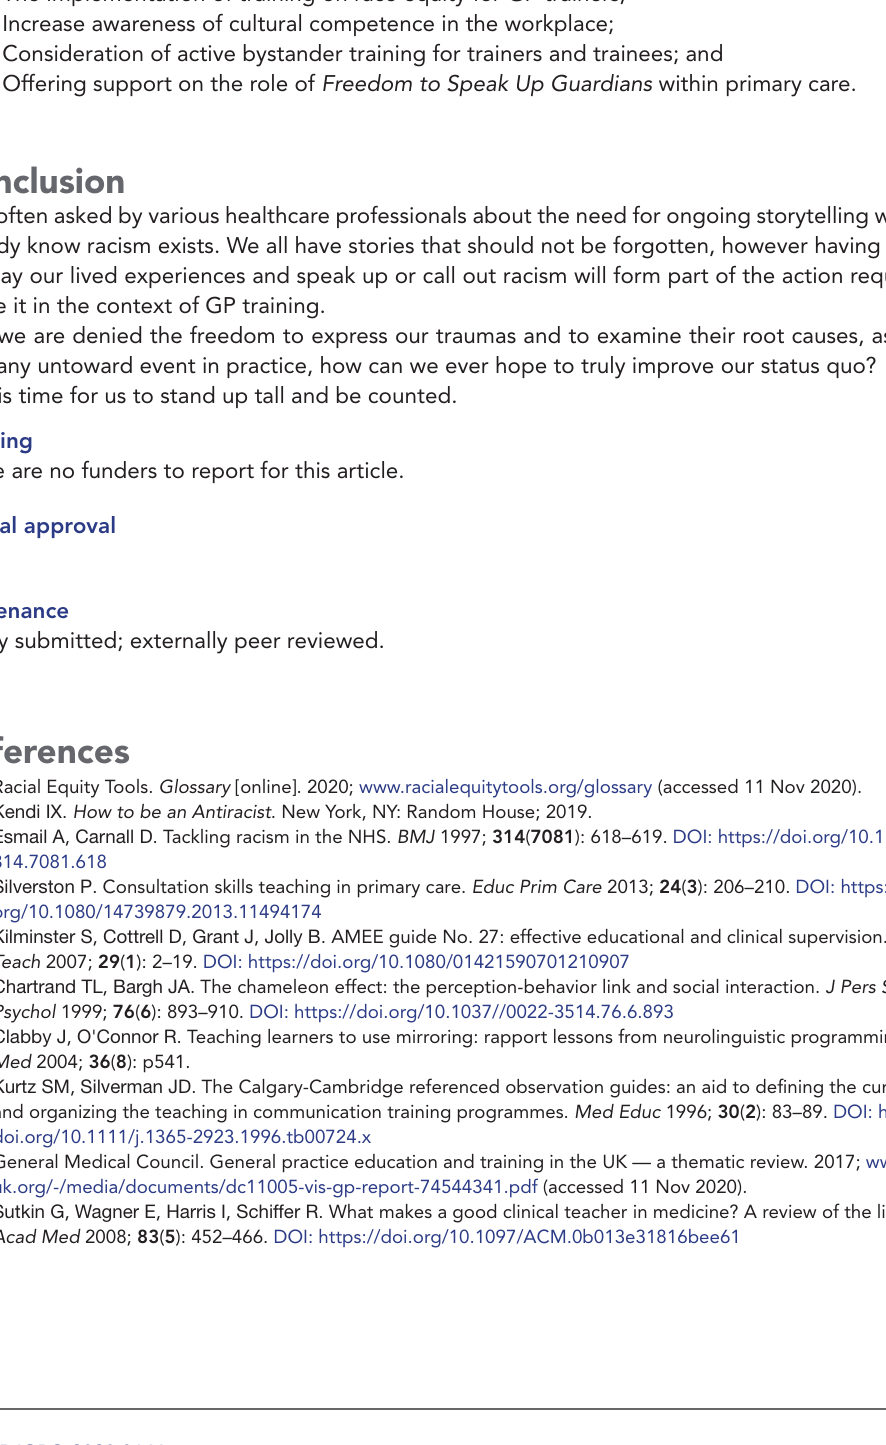
Ikpoh M. BJGP Open 2020; DOI: